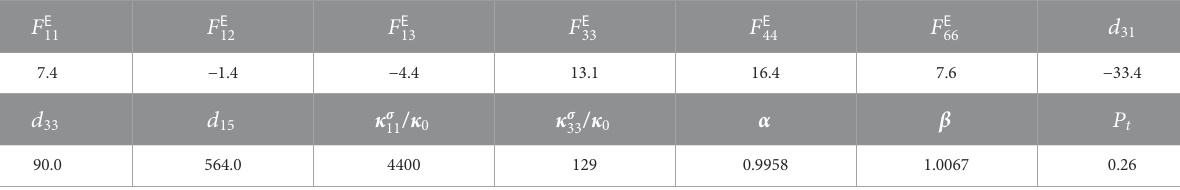
TABLE 1 Theelectromechanicalmoduli M ofsingle-domainwith polarizationalong [001] initscubic crystallographicaxes( F E : 10 – 12 m 2 /N; d :10 – 12 C/N; κ σ / κ 8.85×10 – 12 C 2 /Nm 2 isthepermittivityoffreespace),transformationstrain ε ;andspontaneouspolarization P (C/m 2 )oftetragonalBaTiO 3 singlecrystal(Zgoniketal.,1994; Liu and Li,